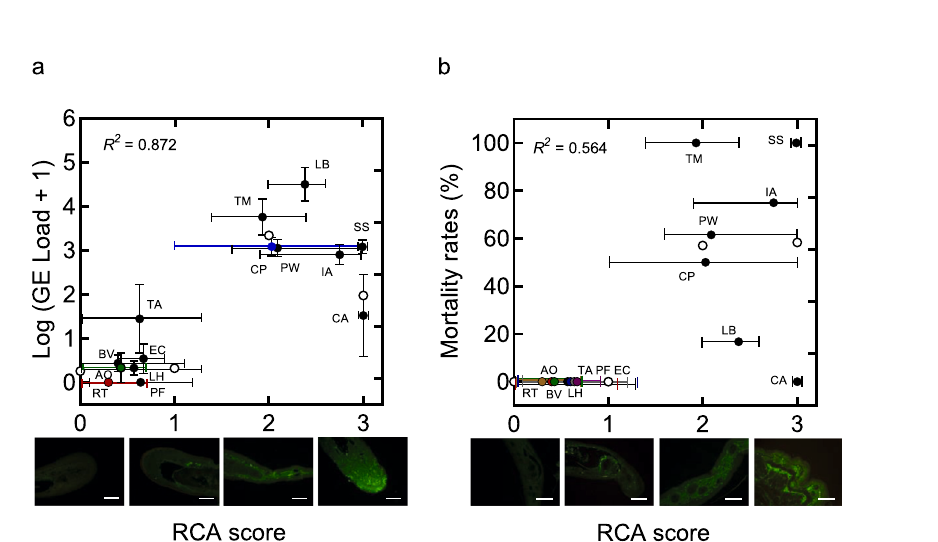
Fig. 4 Susceptibility to B. salamandrivorans infection correlates with life stage dependent skin galactose presence. a B. salamandrivorans infection loads (expressed as genomic equivalents (GE)) on fi re salamander larvae ( n = 37 biologically independent animals) and metamorphs ( n = 6 biologically independent animals) 10 days after exposure to 1.5 × 10 5 spores/ml for 24 h. In the boxplots, horizontal lines represent median and interquartile ranges, with the vertical line representing min/max. Dots represent outliers, whiskers indicate highest/lowest value within 1.5*IQR from hinge. B. salamandrivorans infection prevalence (IP) of fi re salamander larvae and metamorphs are shown. b Macroscopic picture of infected fi re salamander metamorphs, arrow indicates skin ulcerations. c Histogram of B. salamandrivorans infection log (GE load + 1) load and equivalent RCA scores of fi re salamander larvae and metamorphs. d Probability of RCA scores in early larvae stage ( n = 21 biologically independent animals), late larvae stage ( n = 16 biologically independent animals), and fi re salamander metamorphs ( n = 6 biologically independent animals) predicted from ordinal logistical regression fi t with polr(), error bars indicate RCA score probability + / − one standard error. Photomicrographs represent different RCA staining scores. RCA score: 1 = weak staining, 2 = strong staining, 3 = intense staining. RCA score of 0 is not shown because no slides were scored 0. Scale bars = 100 µ m. Morphological characters of fi re salamander larvae and metamorphs are shown. e B. salamandrivorans infection log (GE load + 1) load and respective RCA scores of individual fi re